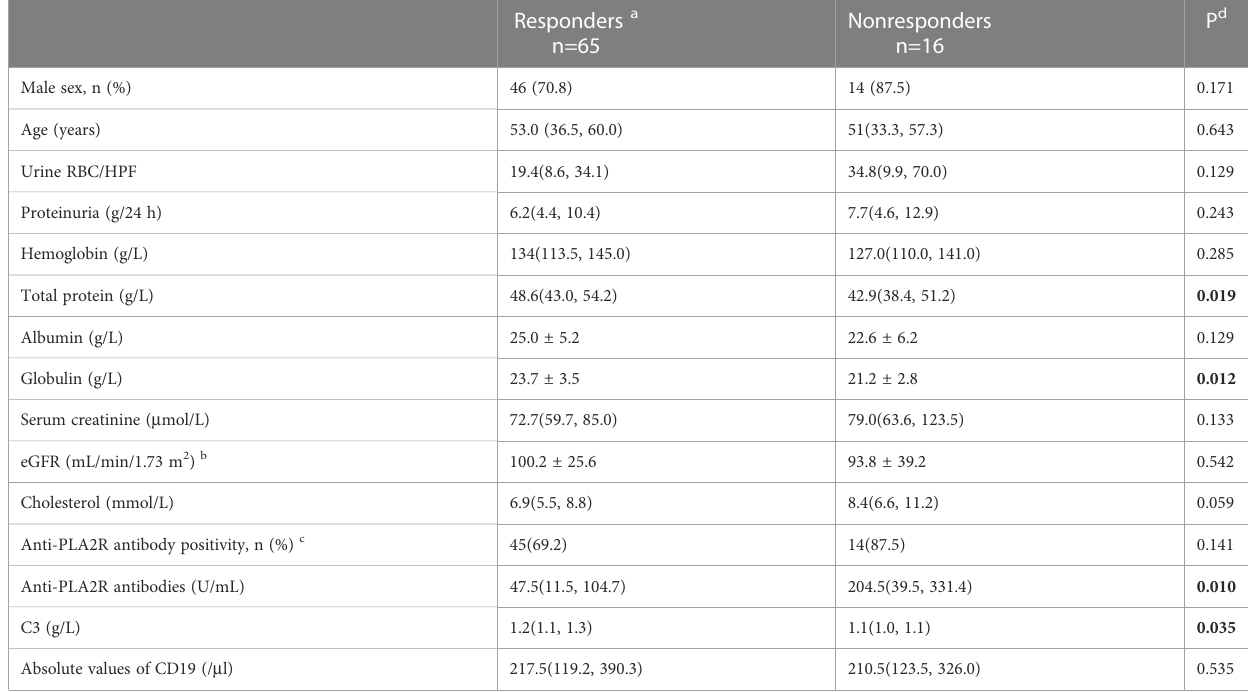
TABLE 4 Composite comparisons of clinical features of patients with PMN between responders and nonresponders.